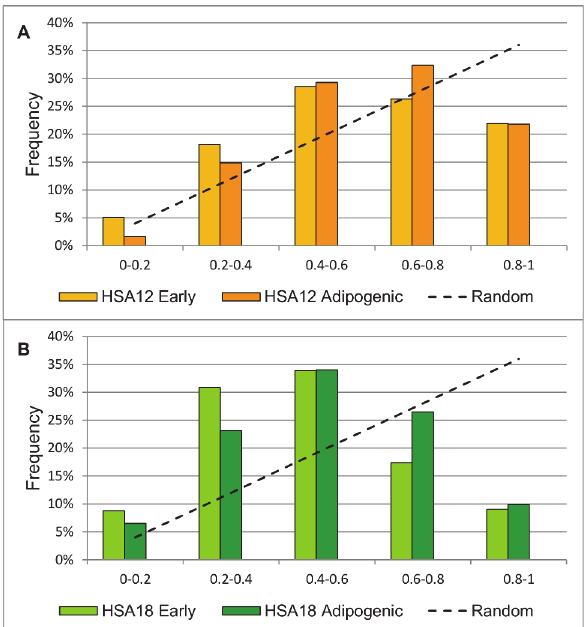
Fig 4. RDCs of HSA12 and HSA18 before and after adipogenic differentiation. RDCs of HSA12 (A) and HSA18 (B) both change after adipogenic differentiation of MSC (p = 0,008 for HSA12 and p = 0,0001 for HSA18). Dashed line demonstrates random distribution for comparison.